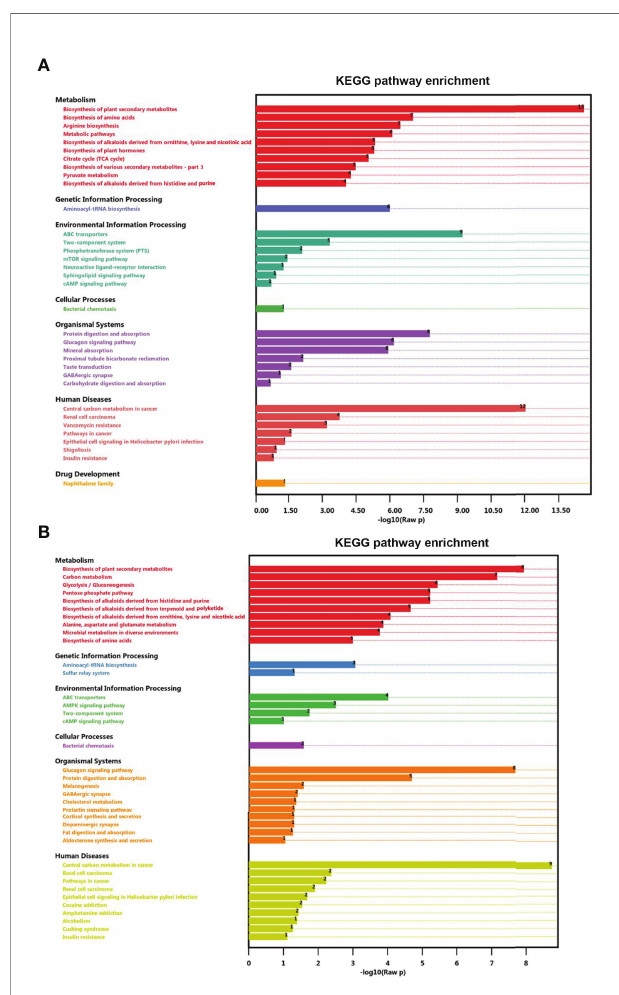
FIGURE 7 | Enrichment of differential metabolites in distinct KEGG pathways. (A) CP vs. CW and (B) EU vs. EW